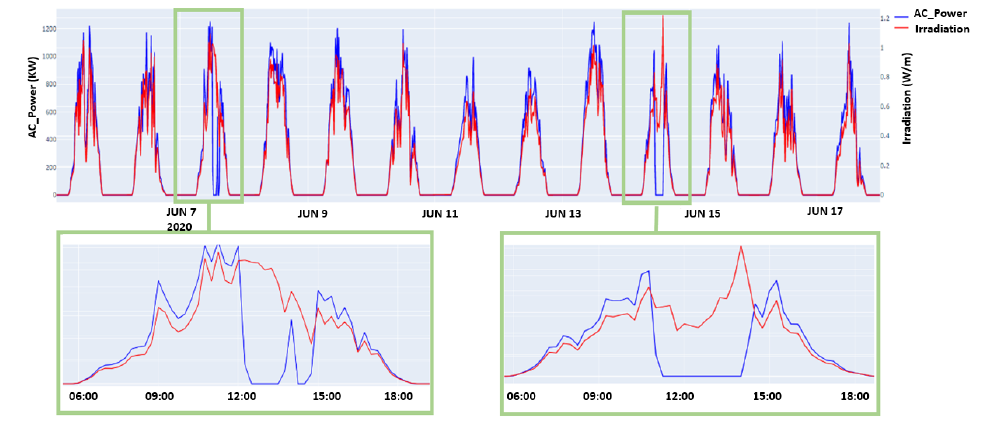
Figure 4. Signal comparison between AC, DC Power, Irradiation, and the Module Temperature signals from inverter number 12.